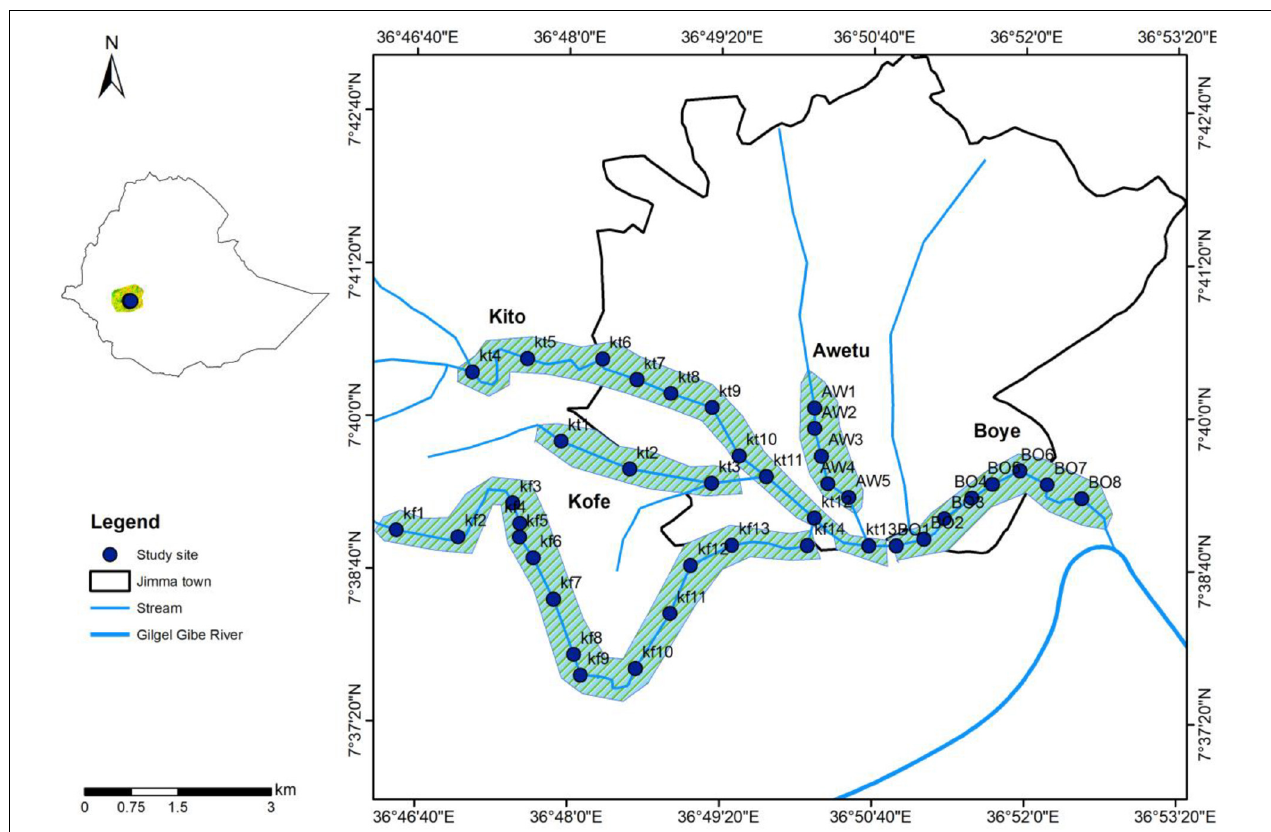
FIGURE 1 | Map of wetland sampling sites in the neighborhoods of Jimma, Southwest Ethiopia (Kf = Kofe, Kt = Kito, AW = Awetu, BO =